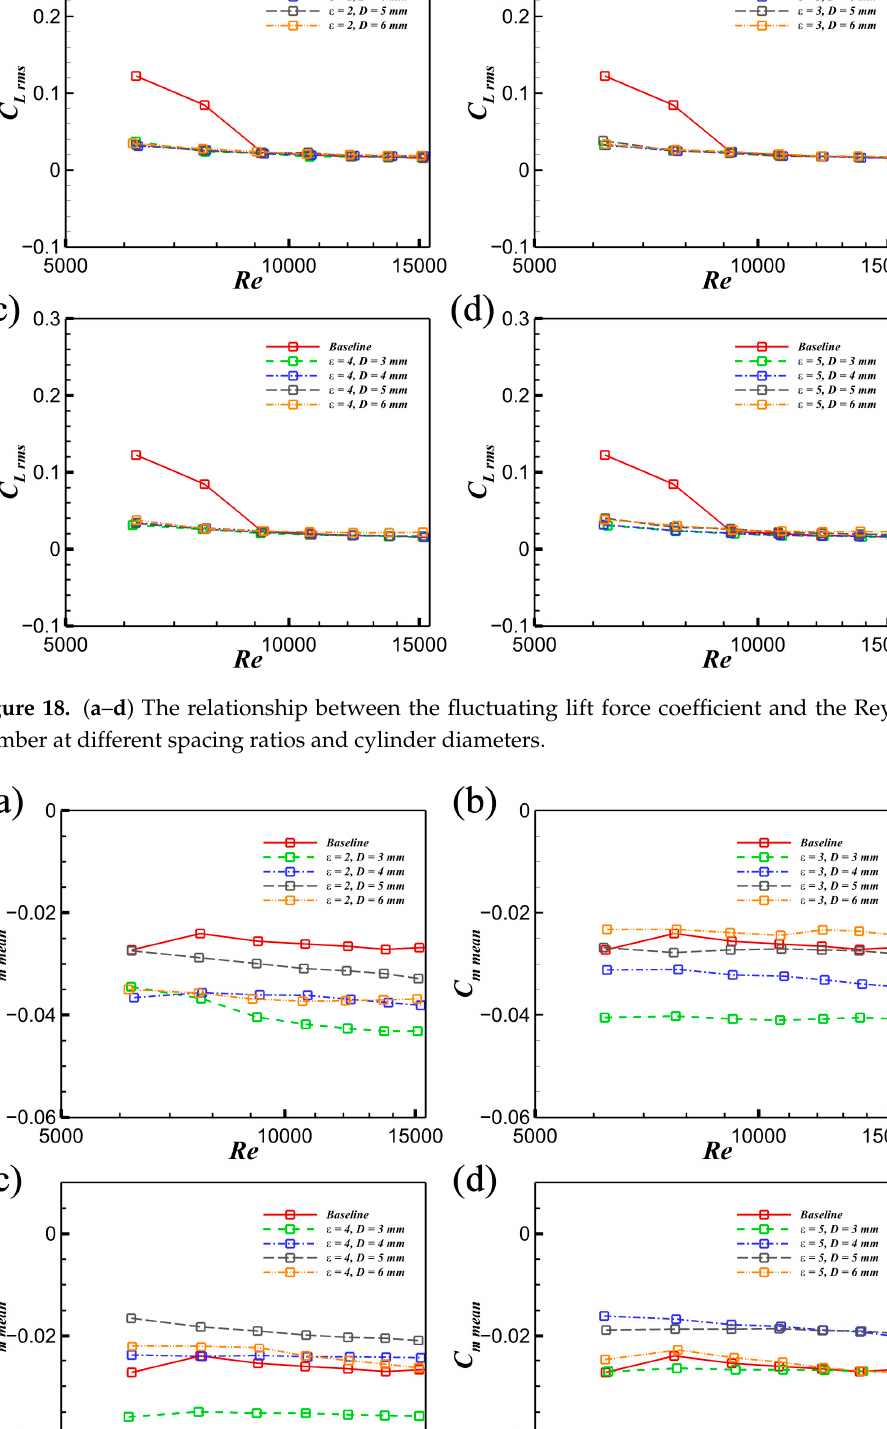
Figure 17. ( a – d ) The relationship between the time-averaged lift force coefficient and the Reynolds number at different spacing ratios and cylinder diameters.